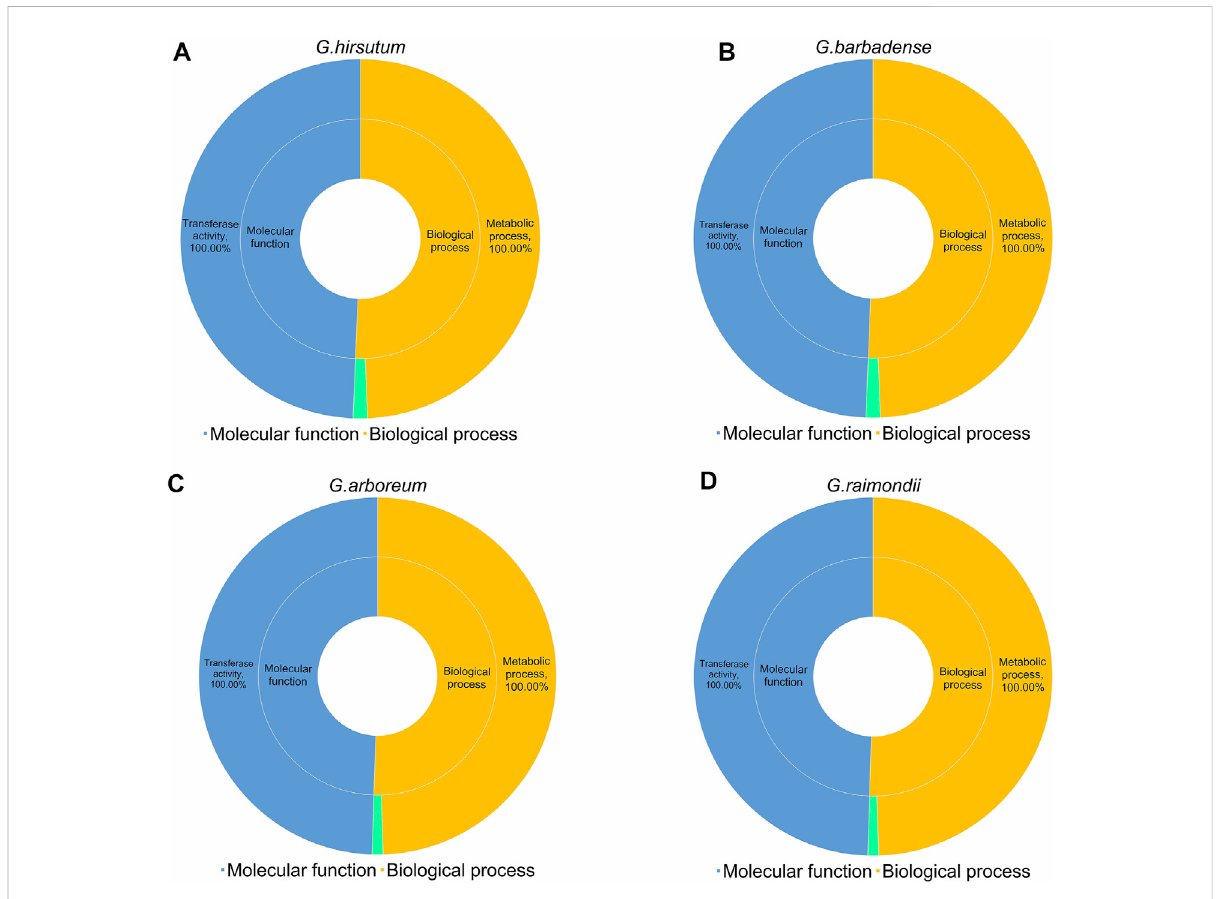
FIGURE 9 GO analysis of 752 UGTs from four cotton species. (A) G. hirsutum. (B) G. barbadense (C) G. arboreum (D) G. raimondii